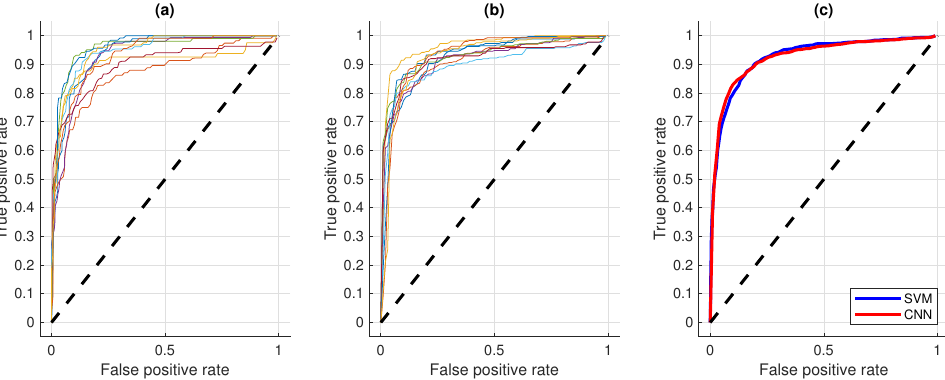
Figure 8. Comparison of the ROC curves of the 10 folds from the SVM ( a ) and CNN ( b ) approaches. The average ROC curves of the SVM (blue line) and CNN (red line) approaches is depicted in ( c ). Their respective AUCs are 92.77 ± 2.95% and 92.51 ±